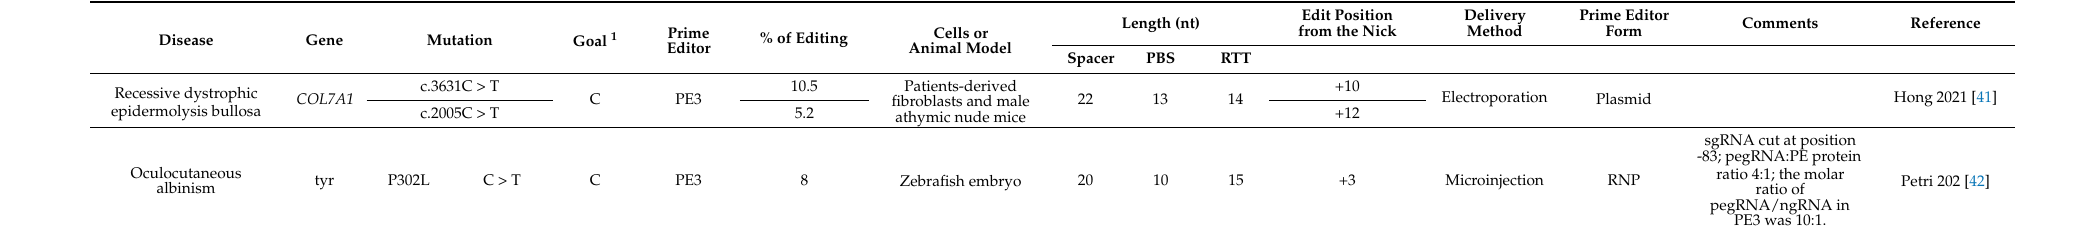
Table 4. Prime editing studies on correcting or introducing genetic mutations causing skin